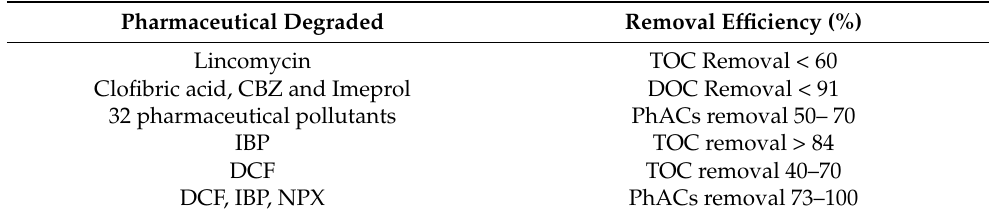
Table 5. Summary of relevant studies on removal of PhACs by PMRs (adapted with permission [97]. Copyright (2019),